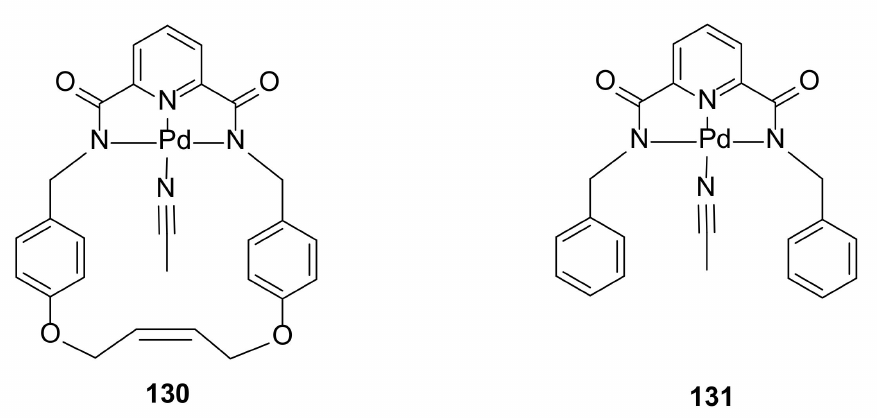
Figure 24. Macrocyclic palladium compound and their acyclic analogue studied for the rate of ligand